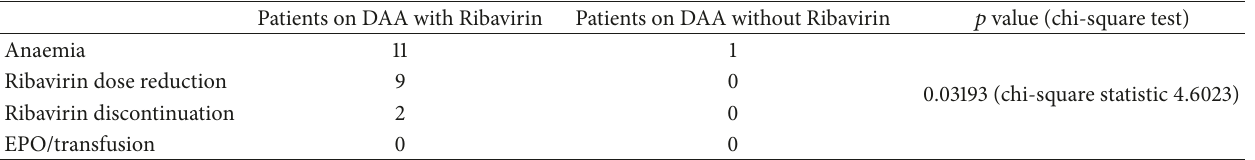
Table 5: Hematological tolerance. Association of anemia with